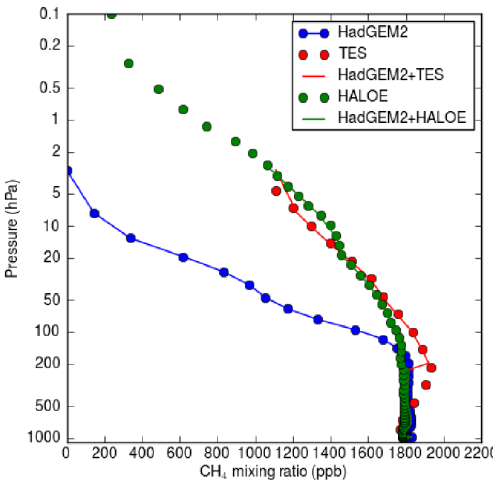
Figure 7. Comparison of the HadGEM2 modelled vertical concen- tration profile of CH 4 with the corresponding profiles from the TES (red) and the HALOE-assimilated TOMCAT model for the grid point (10 ◦ N, 1 ◦ E) in July 2005. The red and green lines show the results from replacing the HadGEM2 modelled concentrations above 200hPa with TES and the HALOE-assimilated TOMCAT output,